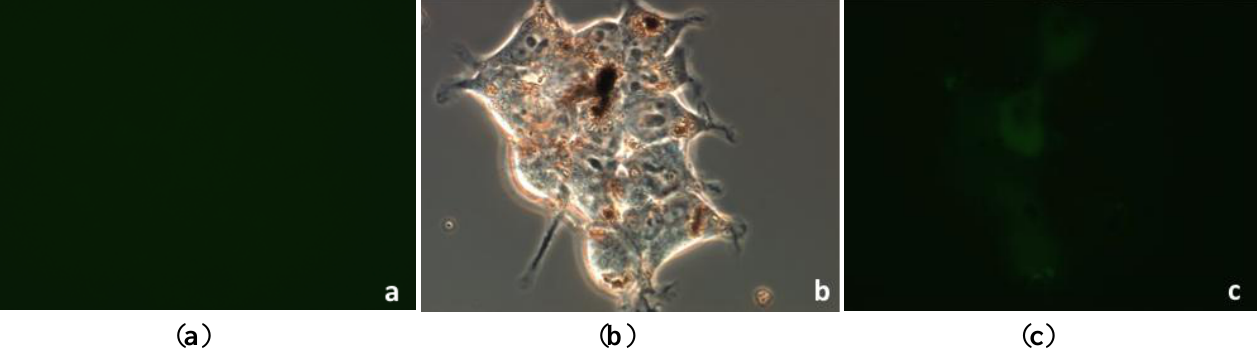
Figure 9. Optical microscopy images of neuroblast cells incubated with Fe particles: ( a ) control sample in fluorescence mode; ( b ) light transmission mode, 60×; and ( c ) fluorescence mode,